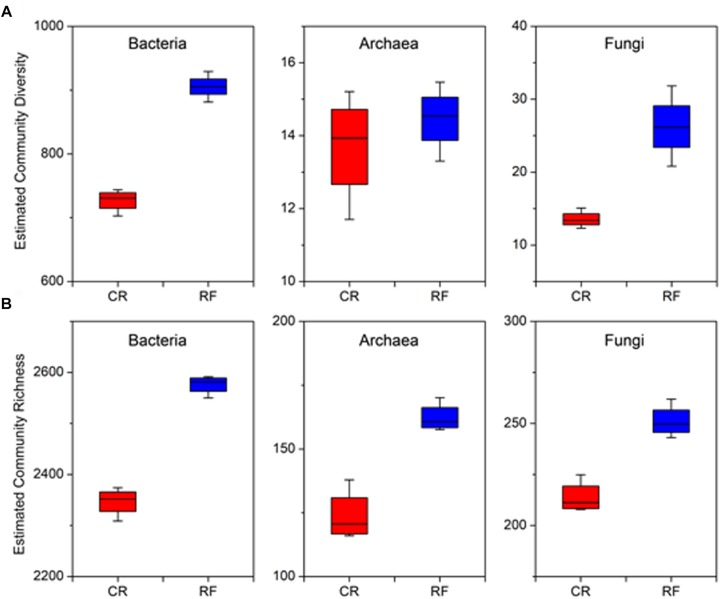
Within-sample (α-diversity) measurements between CR and RF. (A) Estimated species richness was calculated as eShannon_entropy. (B) Abundance-based coverage estimator (ACE) index. The horizontal bars within the boxes represent the median. The tops and bottoms of the boxes represent the 75th and 25th quartiles, respectively. The upper and lower whiskers extend 1.5× the interquartile range from the upper and lower edges of each box, respectively. All outliers are plotted as individual points. CR, conventional rice cultivation; RF, rice-frog cultivation.